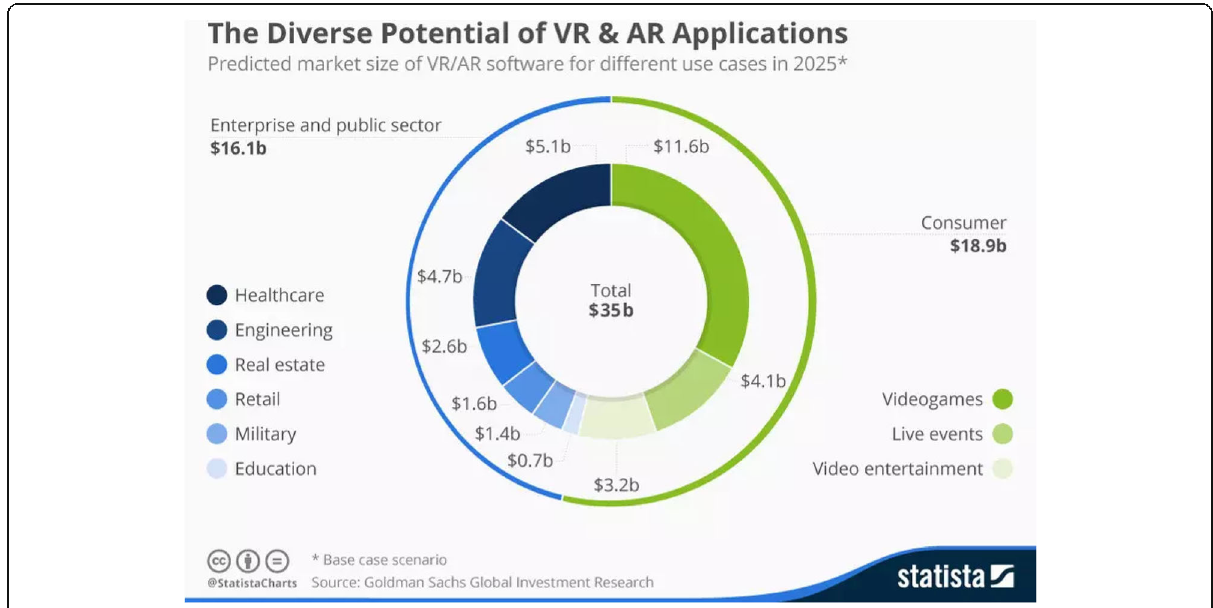
Fig. 16 Estimated scenario of AR/VR in different sectors in 2025 (source: Goldman Sachs Global Investment Research,